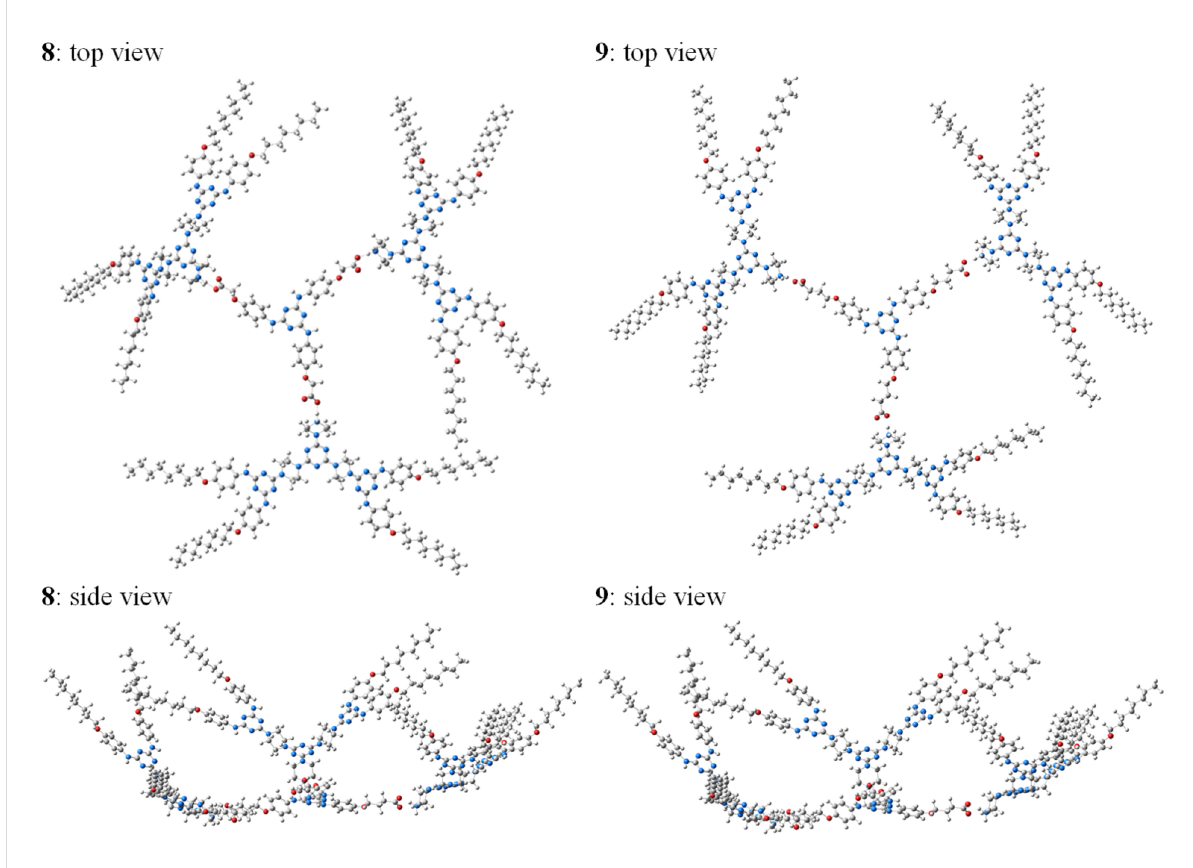
Figure 8: The DFT optimised geometry at M062X/def2-TZVP level of theory of G-2 dendrimers 8 and 9 in DMSO.